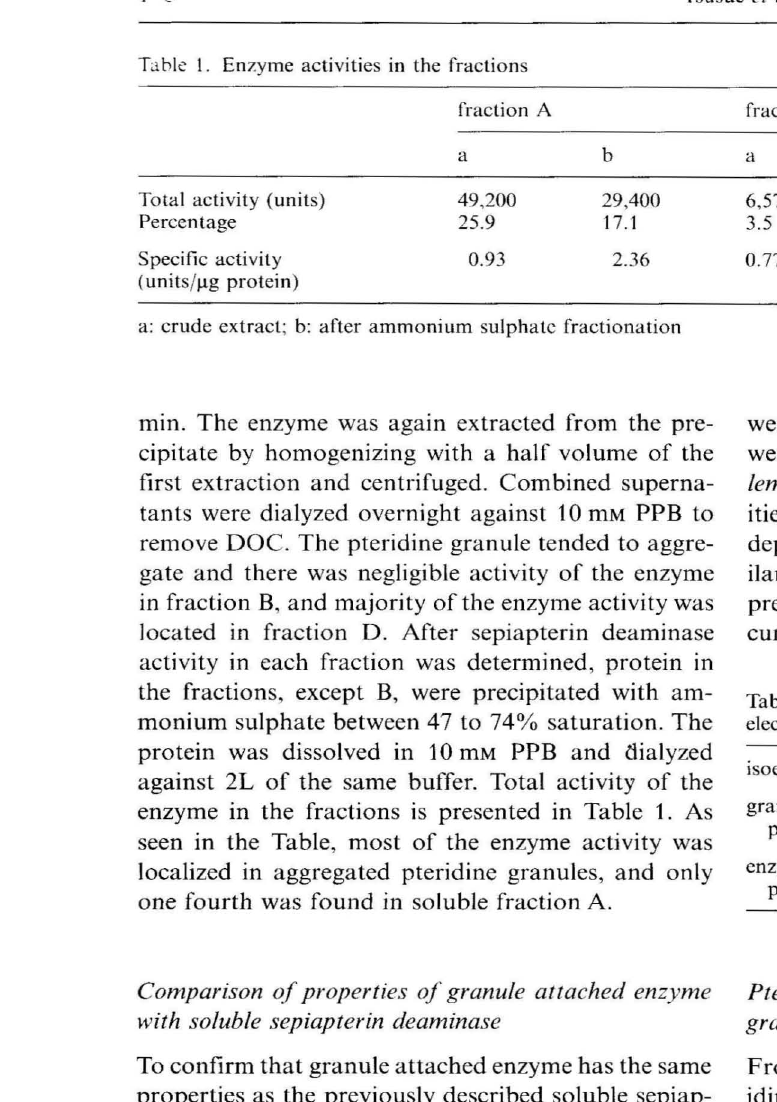
Table 1. Enzyme activities in the